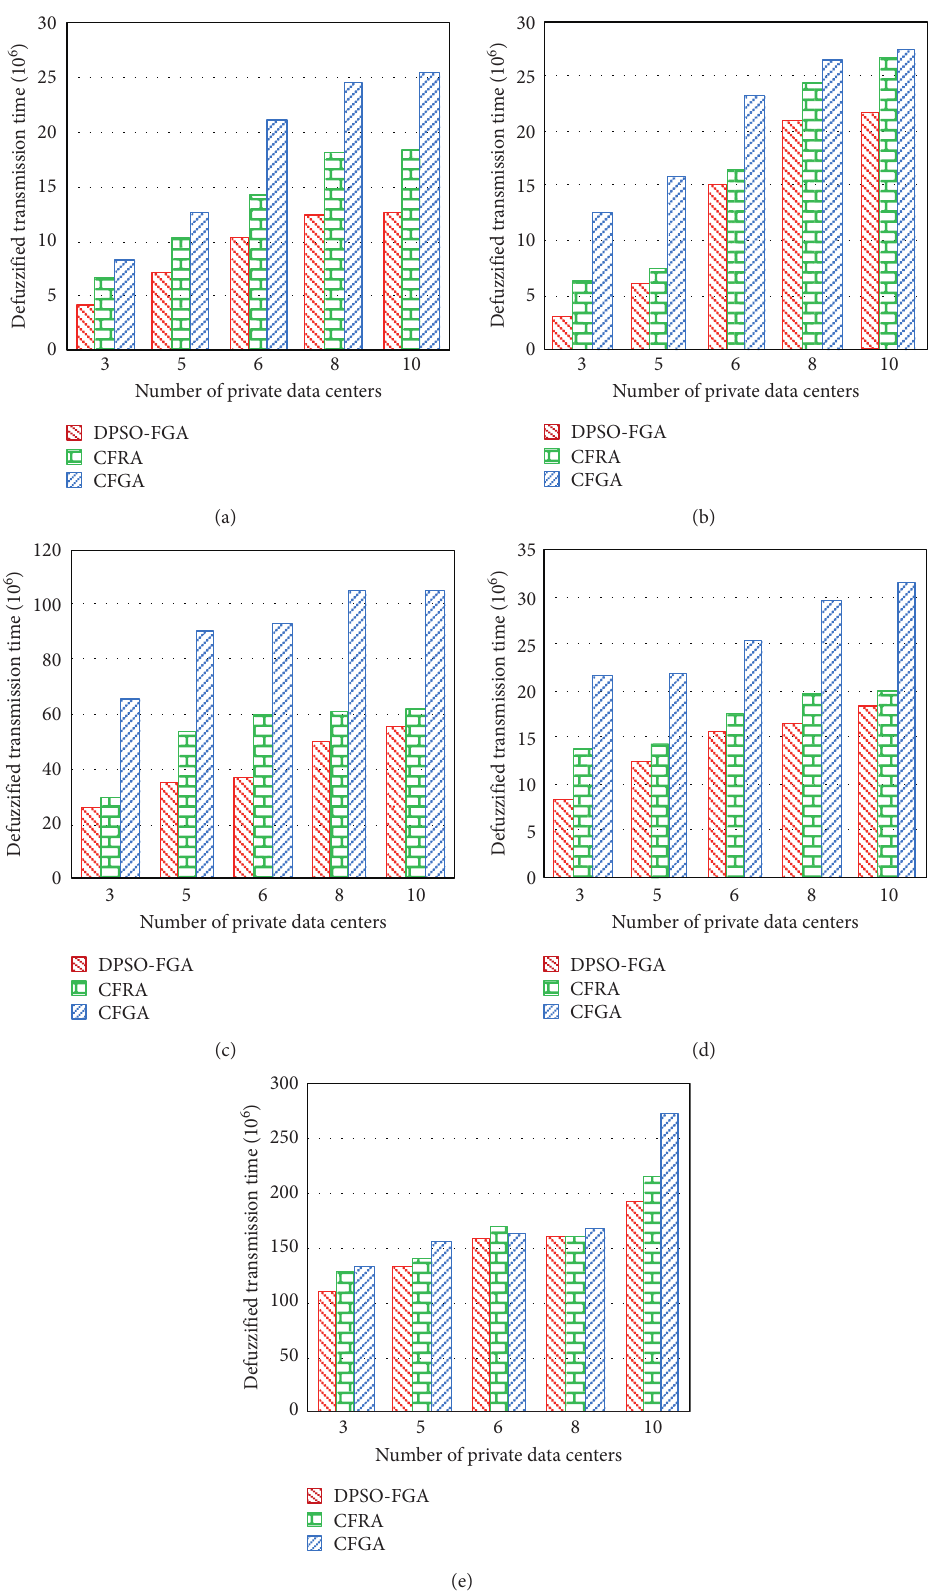
Figure 2: Average data transmission time of different algorithms with various numbers of private data centers: (a) Cybershake; (b) Epigenomics; (c) Inspiral; (d) Montage; (e)